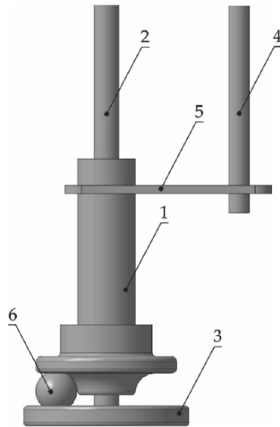
Figure 6. Cathode construction for niobium coating deposition on spherical substrates. Description in the text.